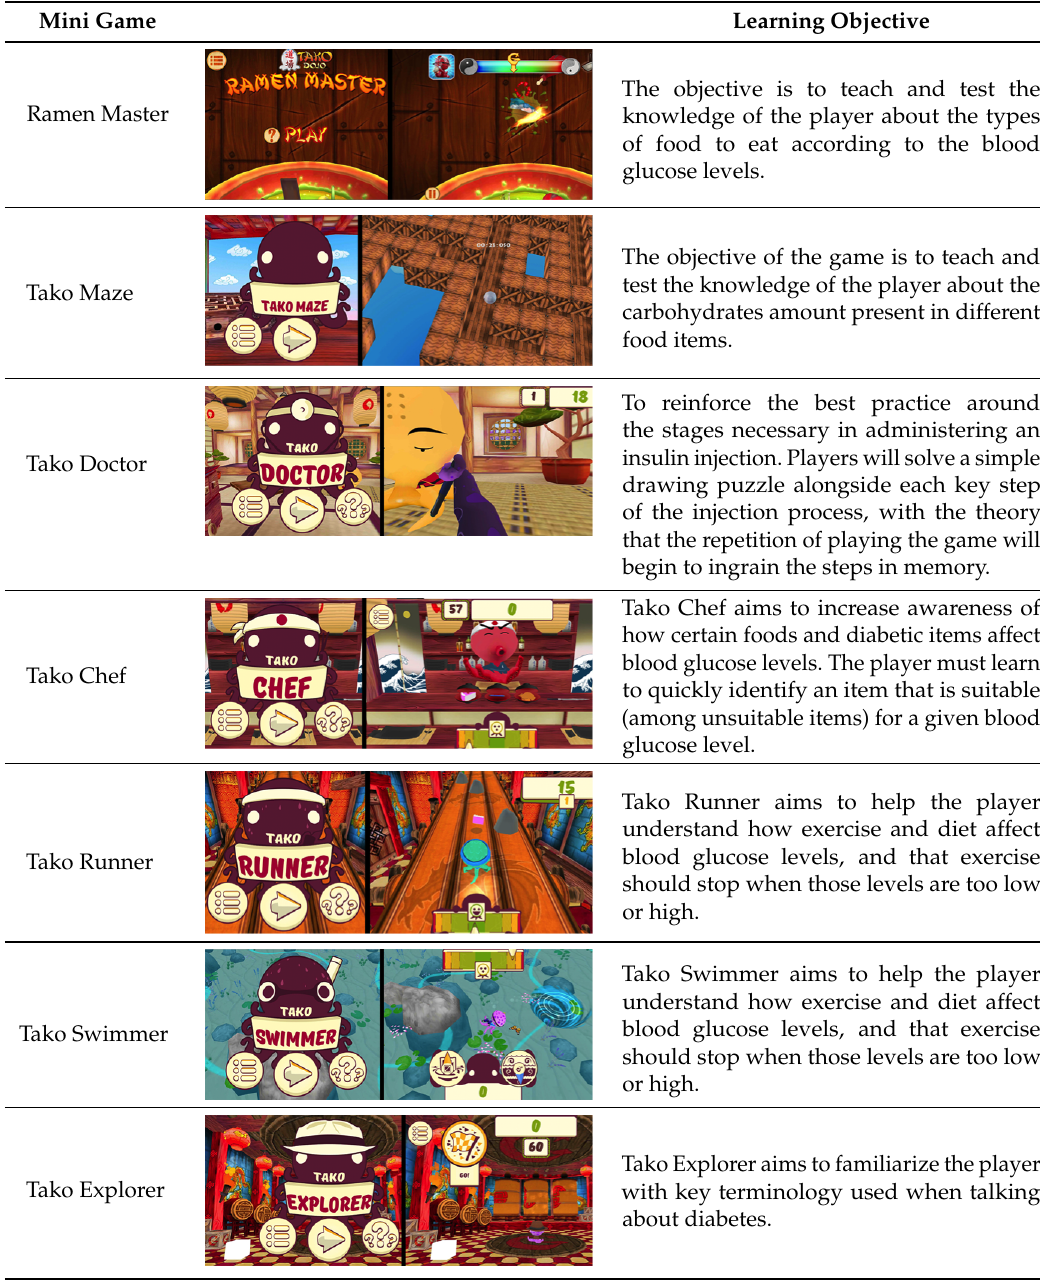
Table 2. Overview of the mini games in the Tiki Tako Game . In the left colom the name of the game and a screen capture, on the right side the learning objective related to this mini